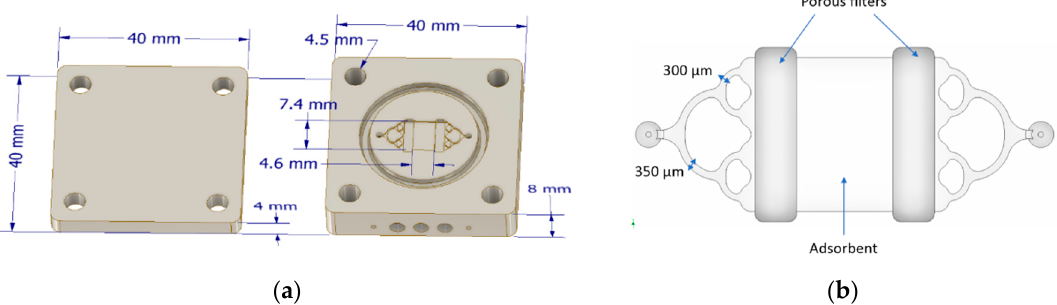
Figure 2. ( a ) Design of the preconcentrator and ( b ) zoom on the microfluidic system and the adsorbent cavity.